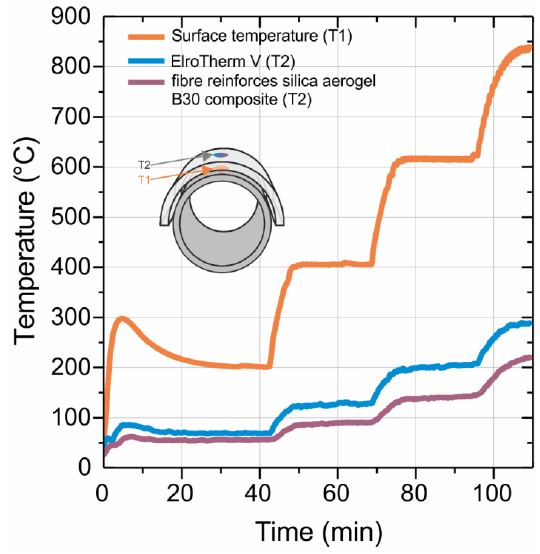
Figure 9. The surface temperature of the respective insulation material (T2) compared to the temperature of the heating device (T1).